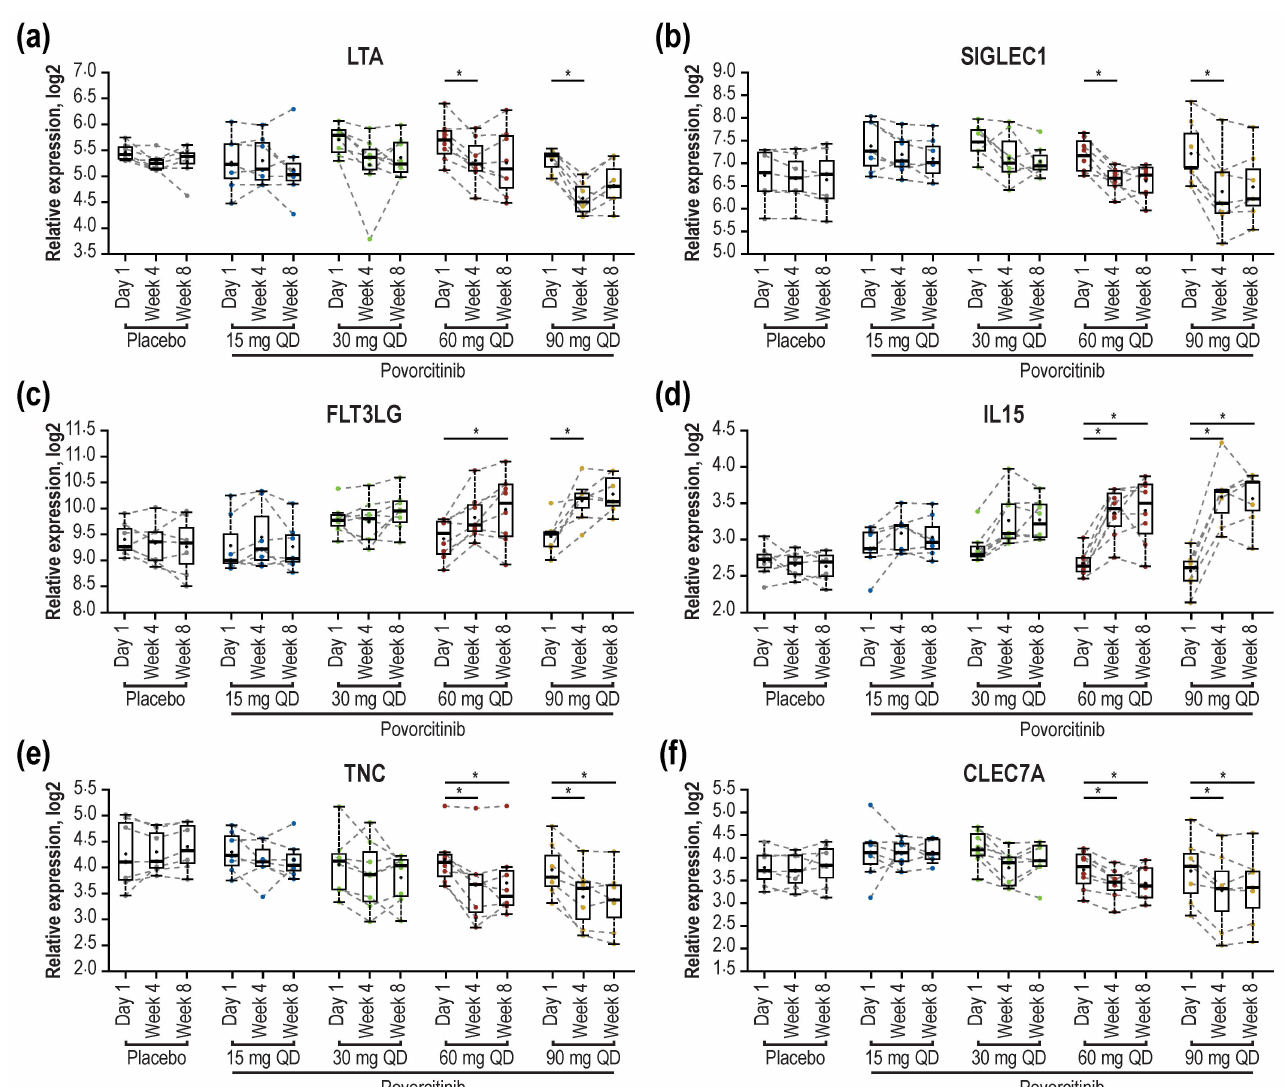
Figure 6. Modulation of circulating protein expression in blood samples over 8 weeks of treatment. ( a ) LTA, ( b ) SIGLEC1, ( c ) FLT3LG, ( d ) IL15, ( e ) TNC, and ( f ) CLEC7A. CLEC7A, C-type lectin domain containing 7A; |FCH|, absolute fold change; FDR, false discovery rate; FLT3LG, Fms-related receptor tyrosine kinase 3 ligand; IL, interleukin; LTA, lymphotoxin-alpha; SIGLEC1, sialic acid-binding Ig-like lectin 1; TNC, tenascin C. * FDR < 0.05. The cutoff for significance was FDR < 0.05 and |FCH| >